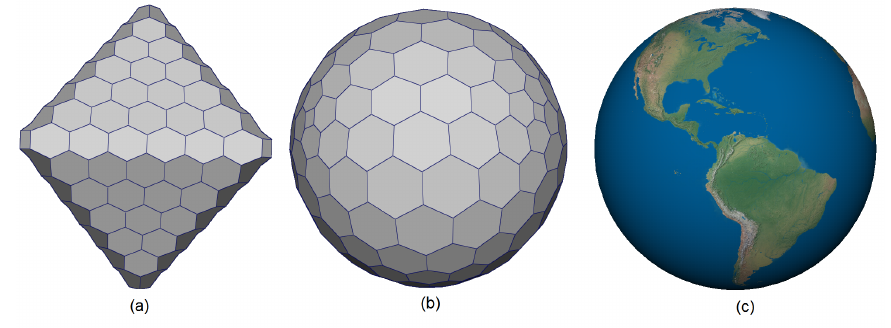
Figure 1. ( a ) A refined polyhedron; ( b ) projecting the polyhedron to the sphere; ( c ) data